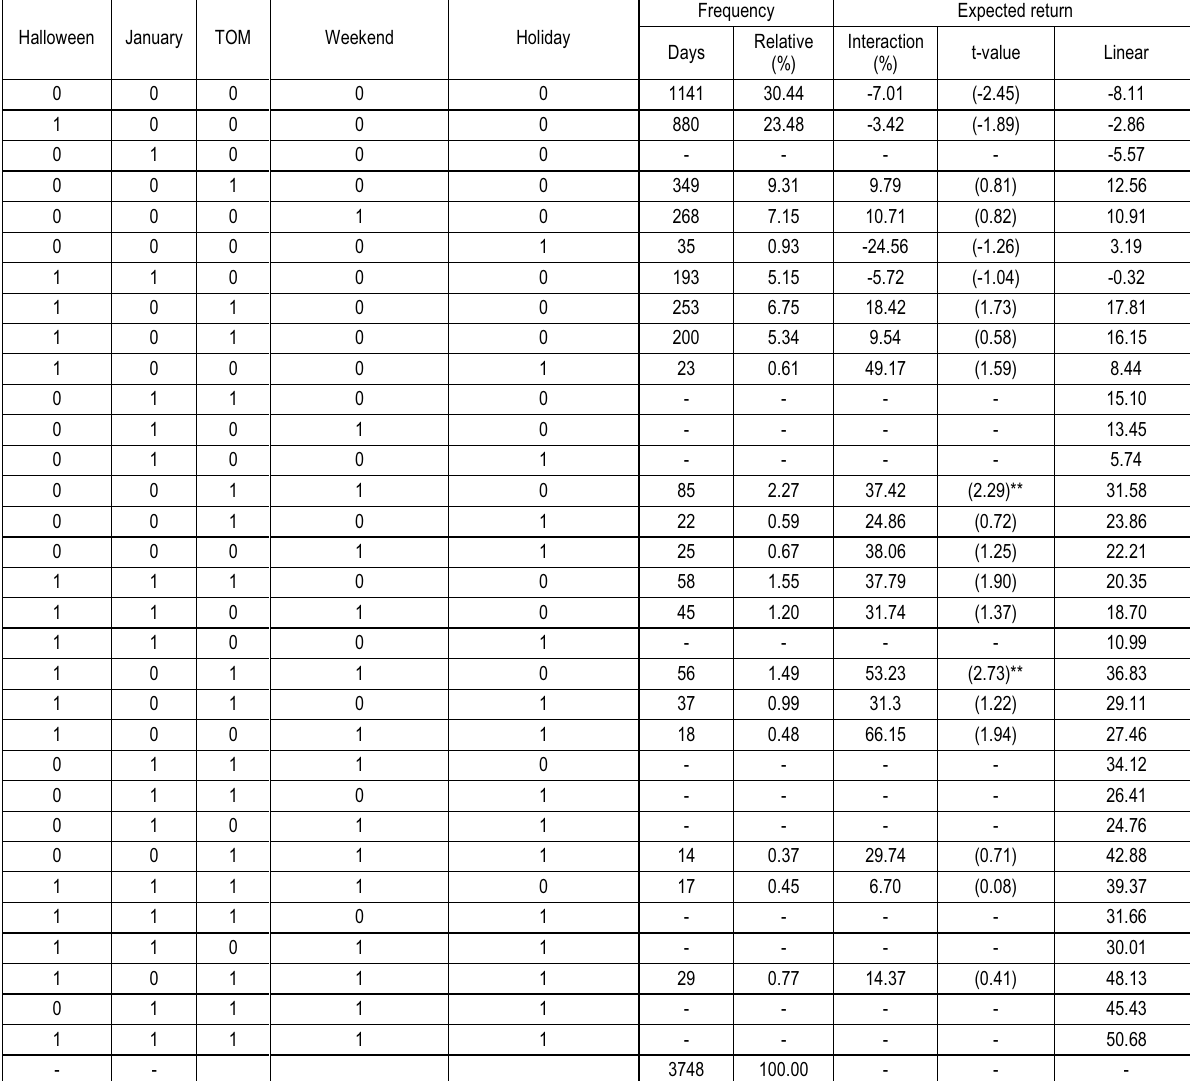
Table 2.The interaction effects among five groups of calendar